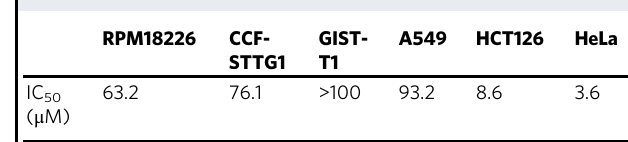
Table. 1 IC 50 values of 1d in various cancer cell